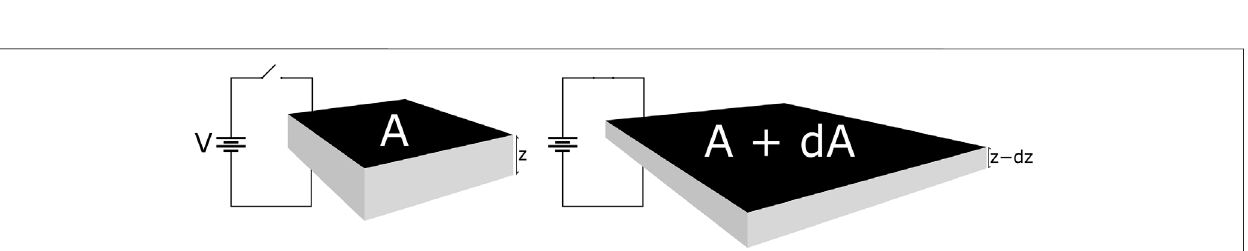
FIGURE 2 | Operating principle of a Dielectric Elastomer Actuator. A is the area of the electrodes and z is the thickness of the dielectric layer, prior to actuation. dA represents the increase in area and dz is the decrease in thickness, after actuating. Applied voltage V is typically on the order of 3 – 5 kV for a membrane thickness of 0.1